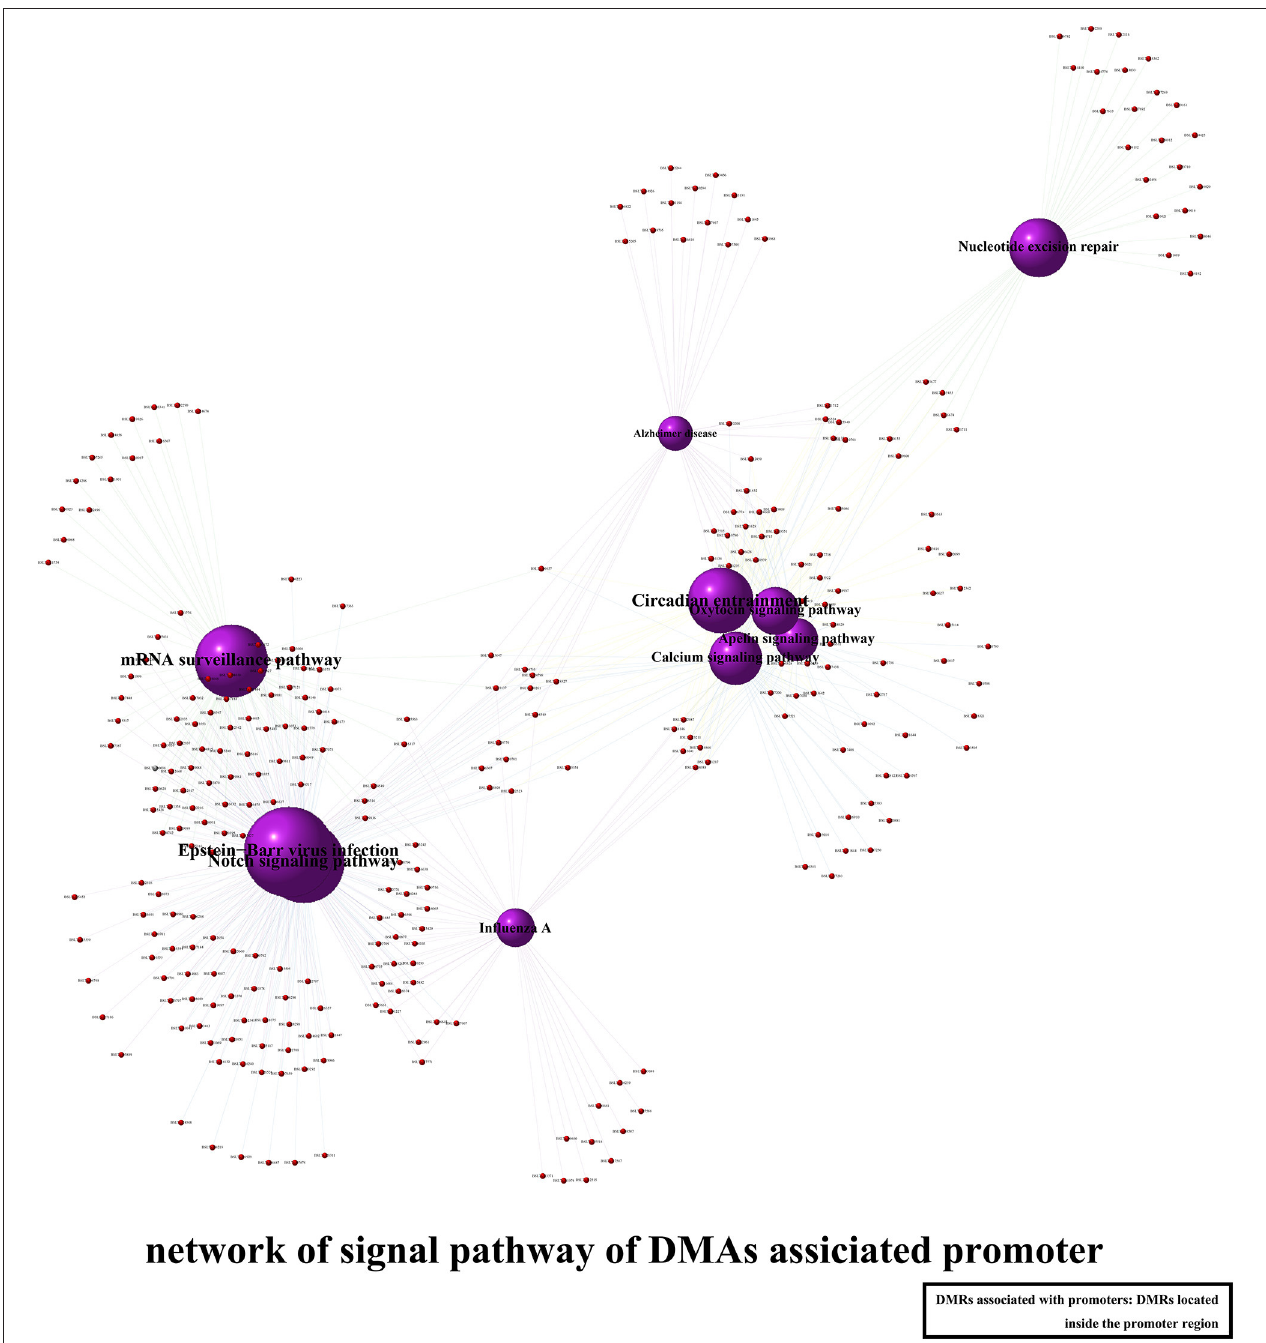
FIGURE 5 | Network of signal pathways via the KEGG enrichment of DMRs associated promoters in all of the three treatments groups simultaneously selected from the Venn diagram.